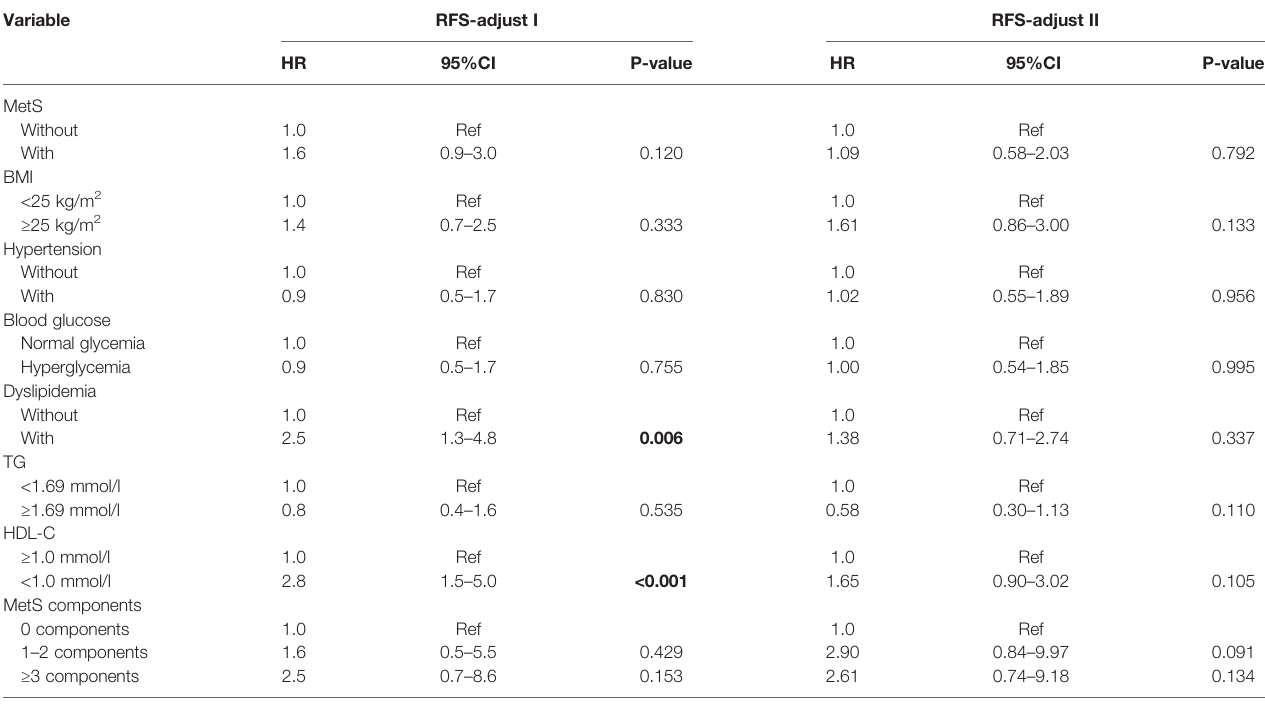
TABLE 5 | Cox multivariate analysis of RFS for MetS and its components in EC patients.